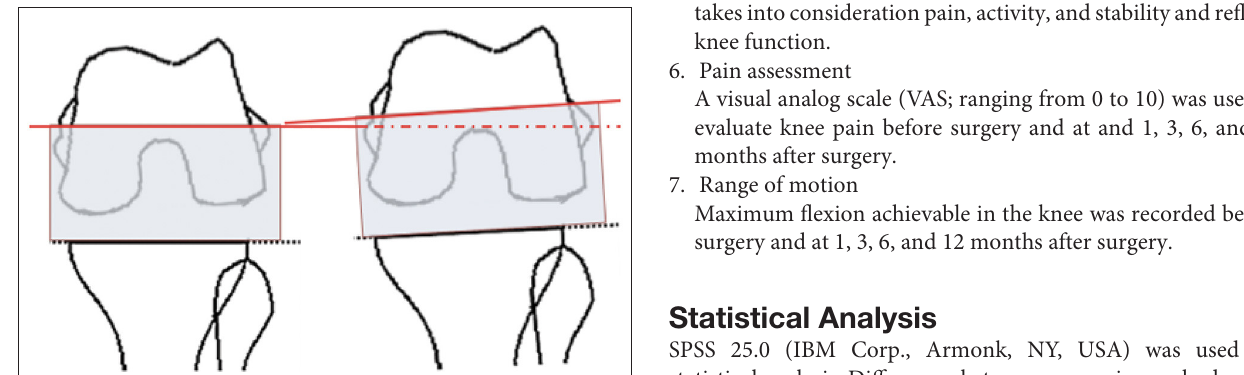
3. Mechanical femoral axis–to–tibial axis angle